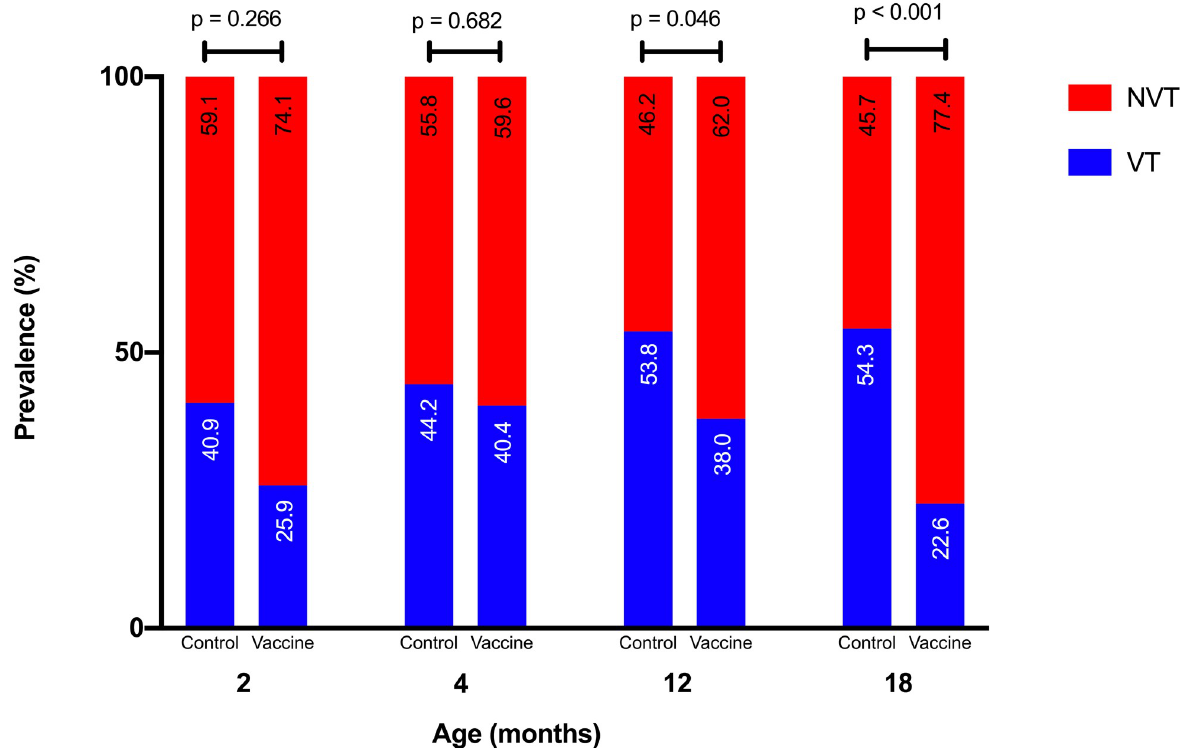
Fig 3. VT and NVT serotype prevalence by age in control and vaccine